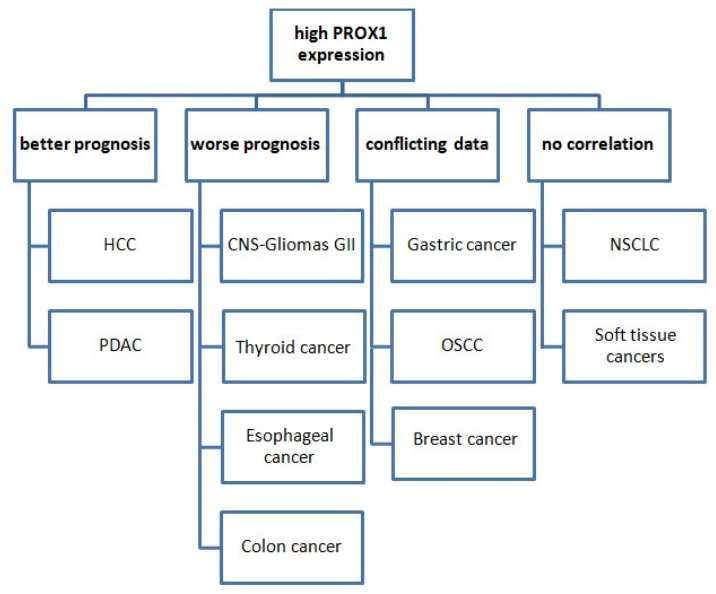
Figure 3. The prognostic value of PROX1 expression in various cancer types. Abbreviations: HCC: hepatocellular carcinoma, PDAC: pancreatic ductal adenocarcinoma, CNS: central nervous system, OSCC: oral squamous cell carcinoma, NSCLC: non-small-cell lung cancer.